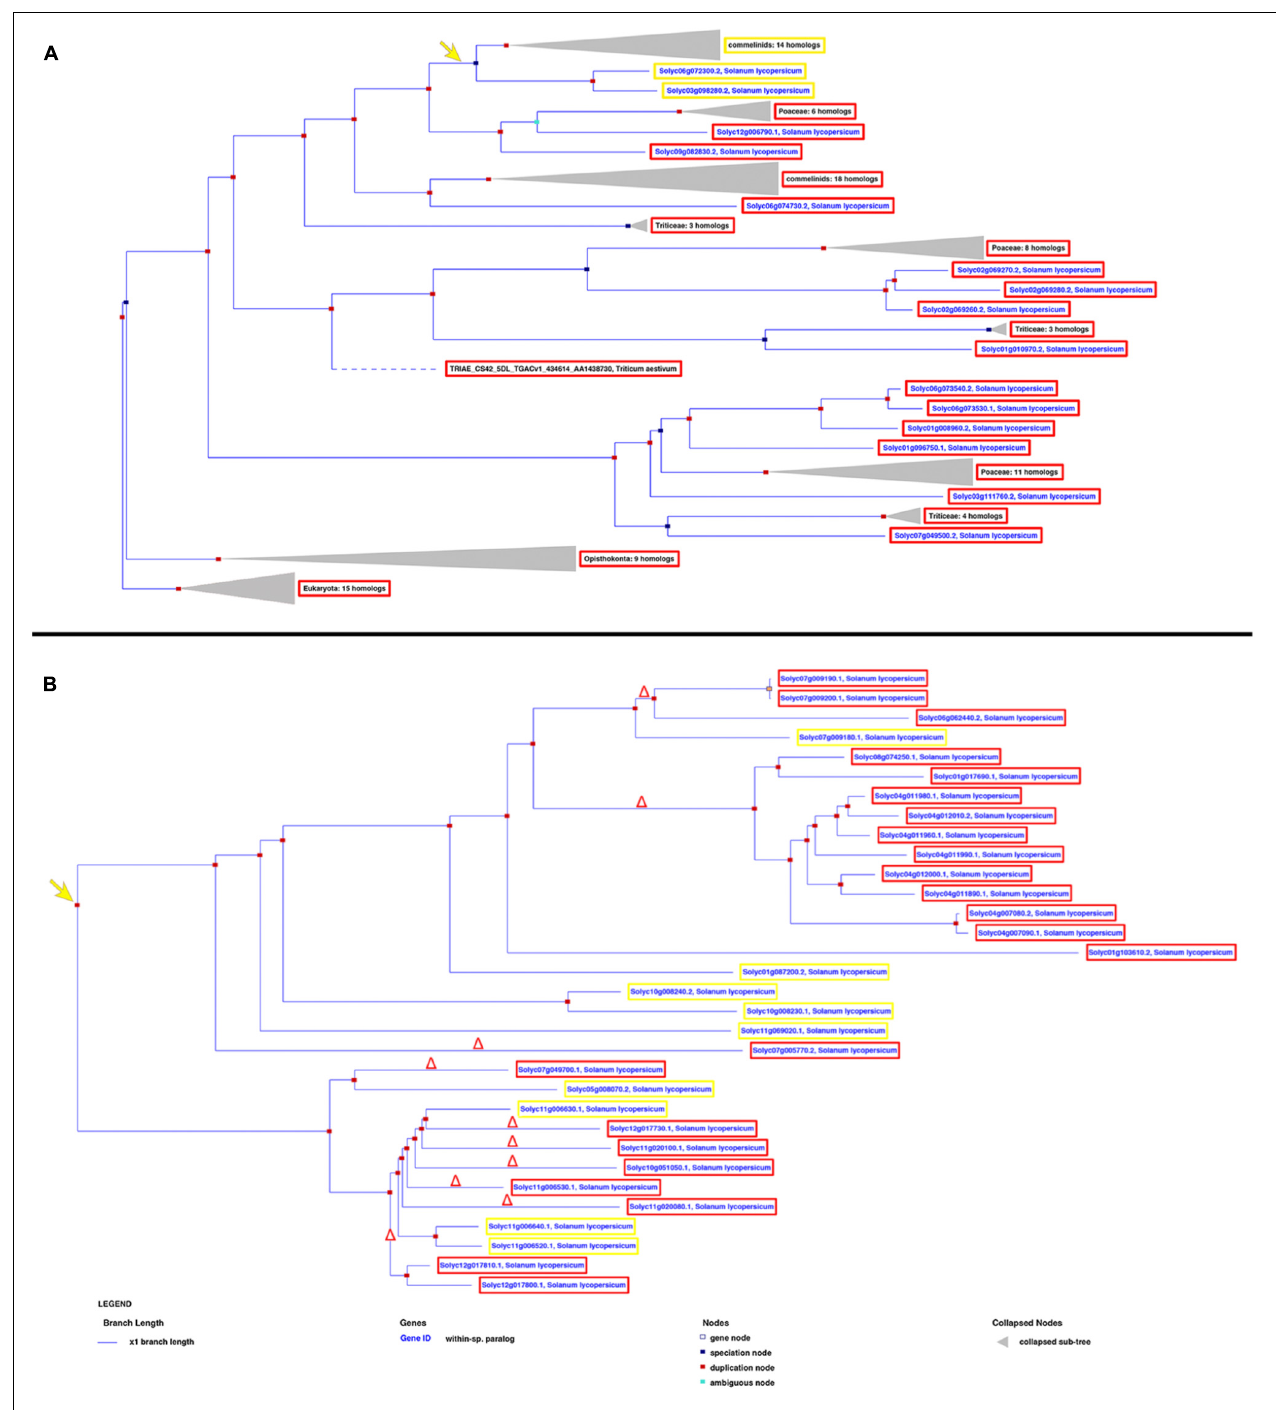
FIGURE 3 | Phylogenetic trees showing the evolutionary history of AGOs (A) and NBS-LRRs (B) in Solanum lycopersicum . The yellow and red frames describe the genes harboring or not the miRNA recognition site, respectively, revealed by both PARE and in silico analyses. The yellow arrow indicates the evolutionary creation of the miRNA target site; the red delta symbol represents the deletion of the miRNA target site.